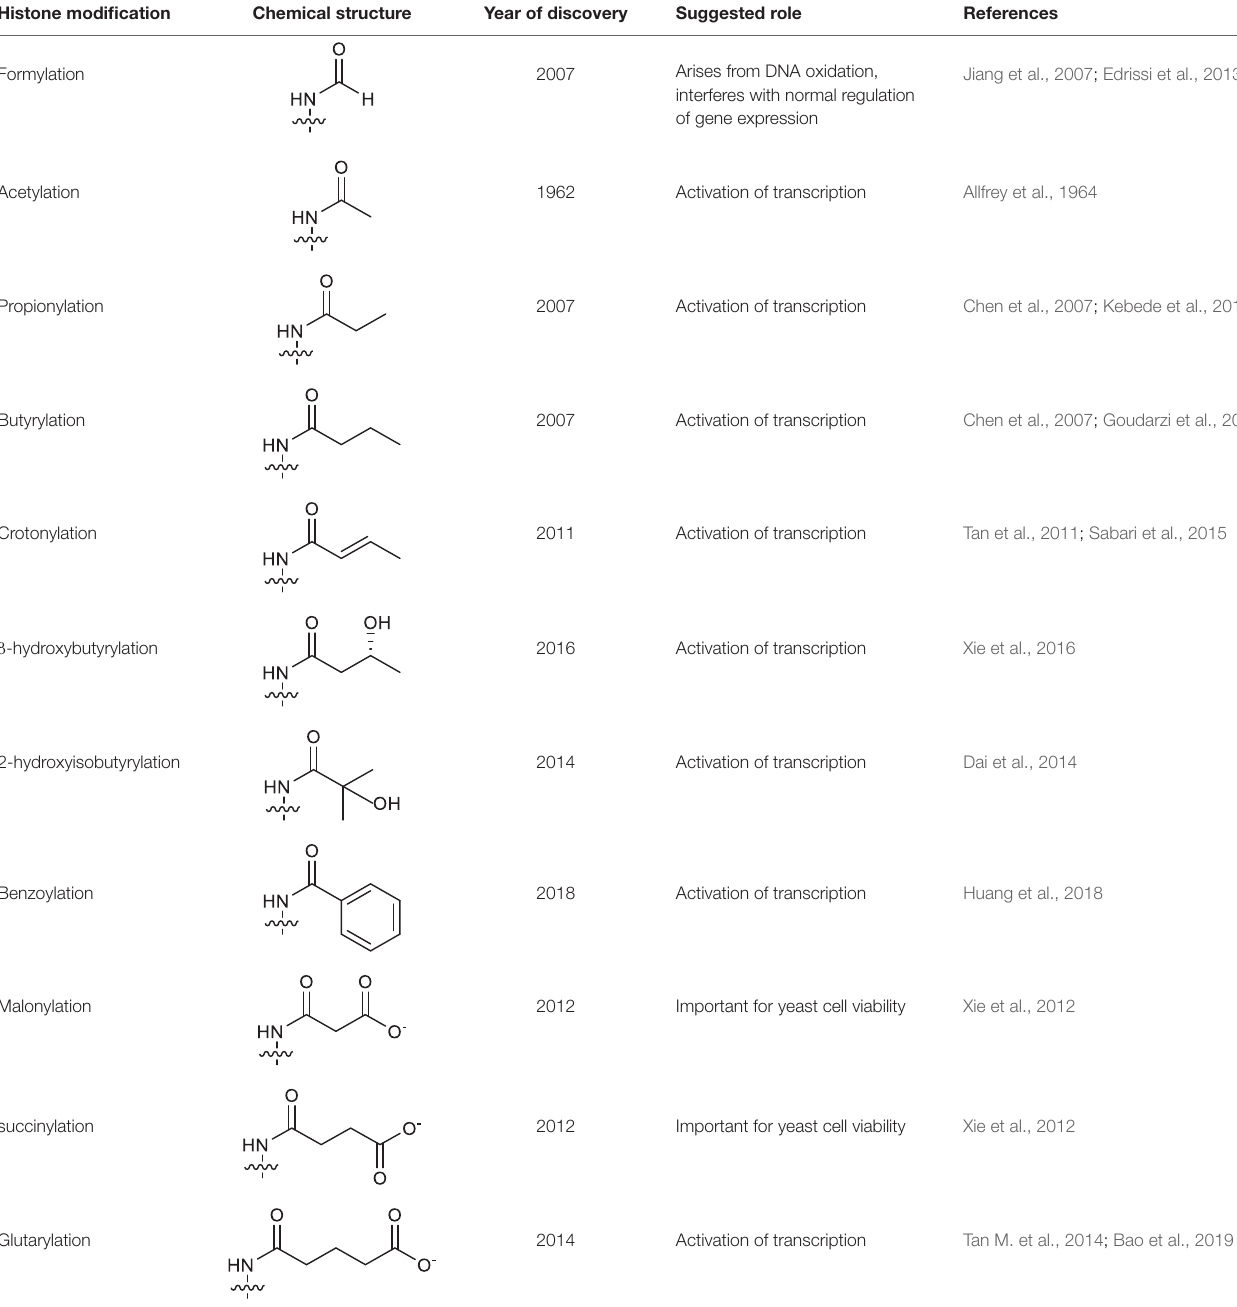
TABLE 1 | Summary of histone Lys